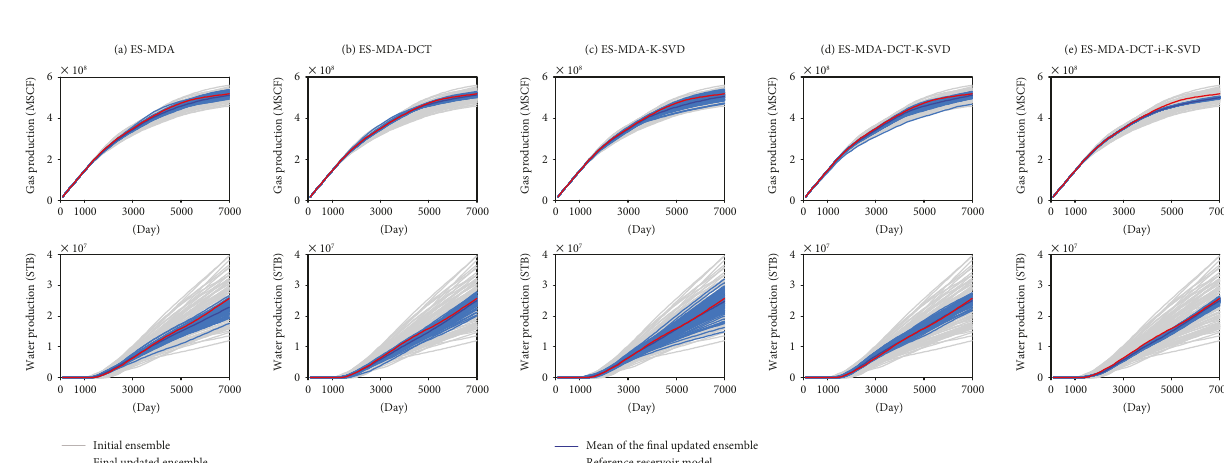
Figure 14: History matching results of Case 2: cumulative gas production and cumulative water production in the fi